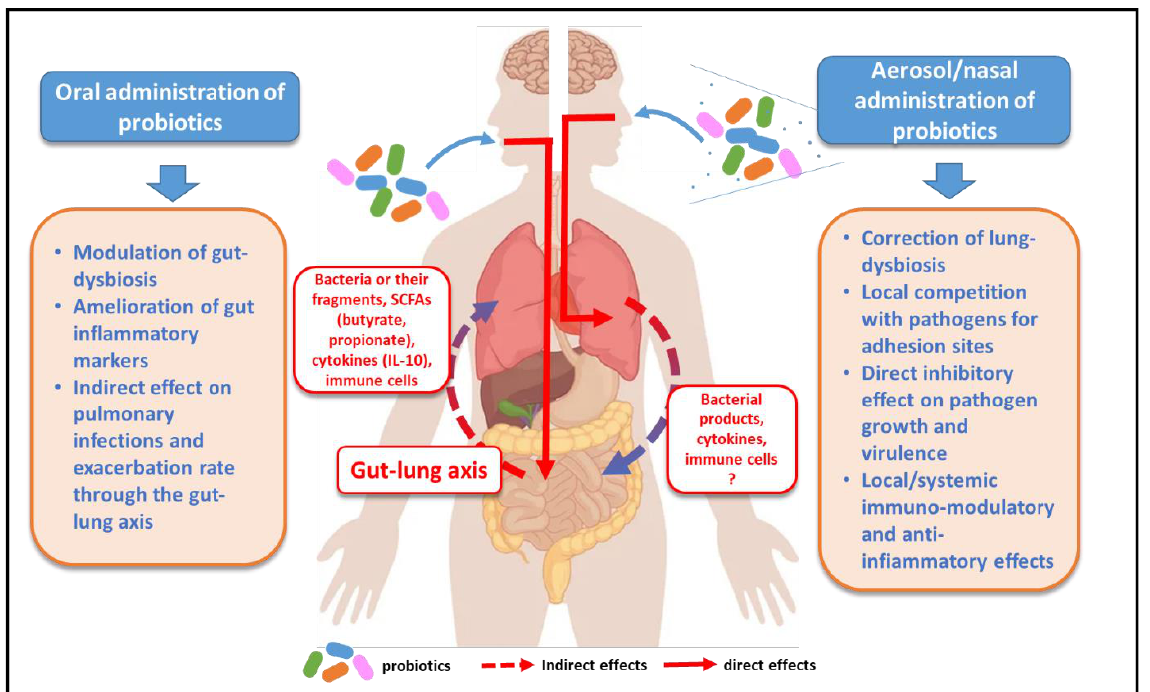
Figure 2. Oral versus aerosol probiotic administration in cystic fibrosis. SCFAs: short chain fatty acids. Although the gut – lung axis is considered bidirectional, the influence of lung microbiota on intestinal immunity has been poorly explored so far.